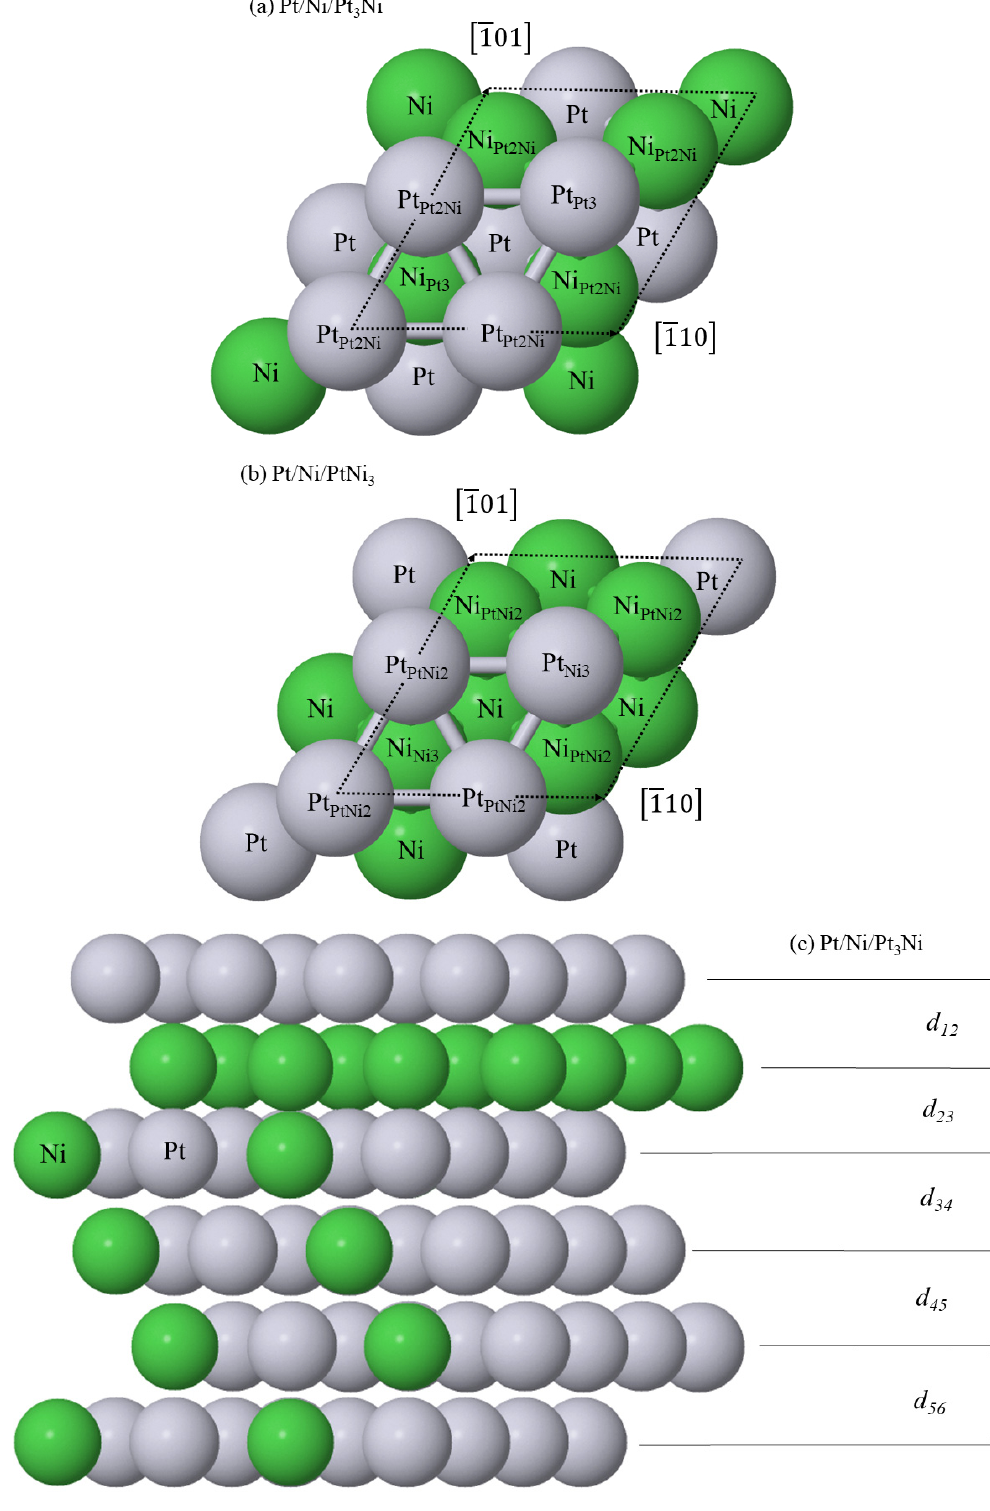
Figure 12. Structure of the surfaces of unreacted ( a ) (111)-Pt/Ni/Pt 3 Ni and ( b ) (111)-Pt/Ni/PtNi 3 and ( c ) the cross-section of unreacted (111)-Pt/Ni/Pt 3 Ni. In the latter, d 12 , d 23 , d 34 , d 45 and d 56 are interlayer spacings. In ( a , b ), the third layer Pt and Ni atoms are labelled by their unannotated chemical symbol, whereas the surface Pt and second layer Ni atoms carry a subscript which is the stoichiometry of their nearest third layer neighbours. This stoichiometry gives rise to non-equivalent on-top, FCC and HCP surface binding positions and three non-equivalent 2-fold bridge